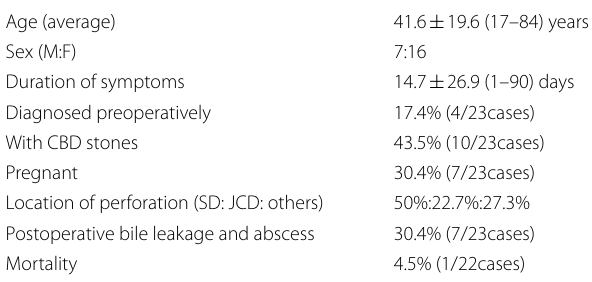
Table 3 Summary of data from 23 case reports of spontaneous common bile duct perforation in adults searched from 2001